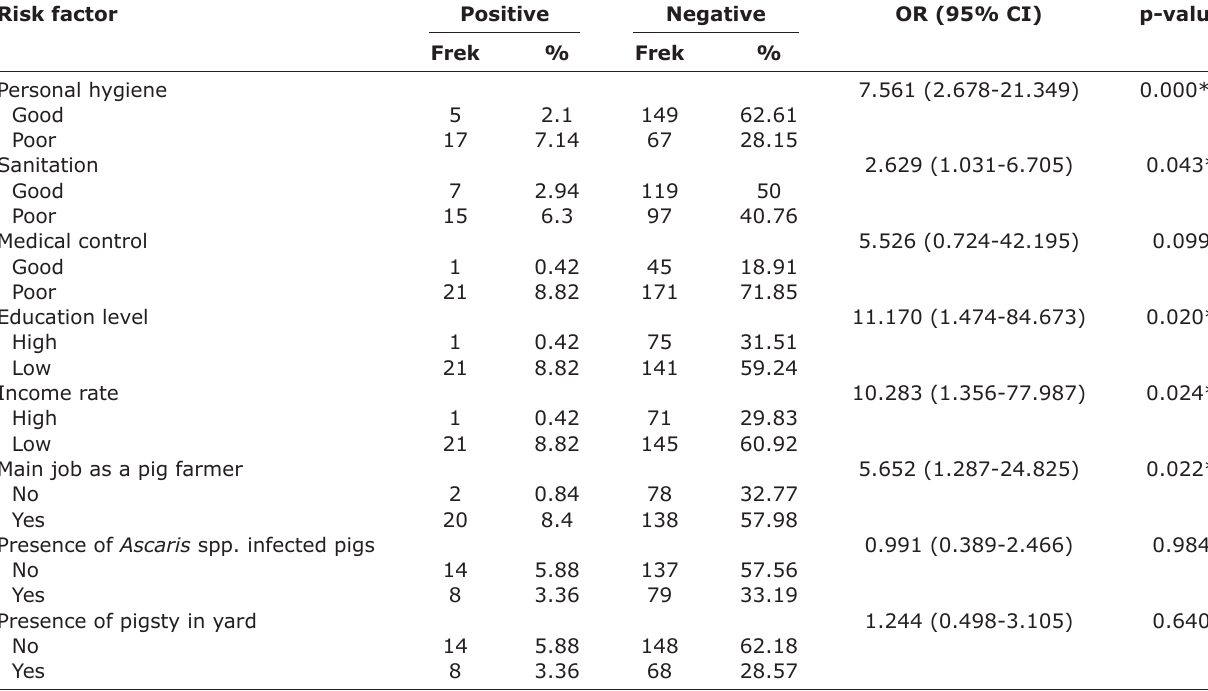
Table-4: Risk factor of Ascaris spp. infection in traditional pig farmers in Bali. Risk